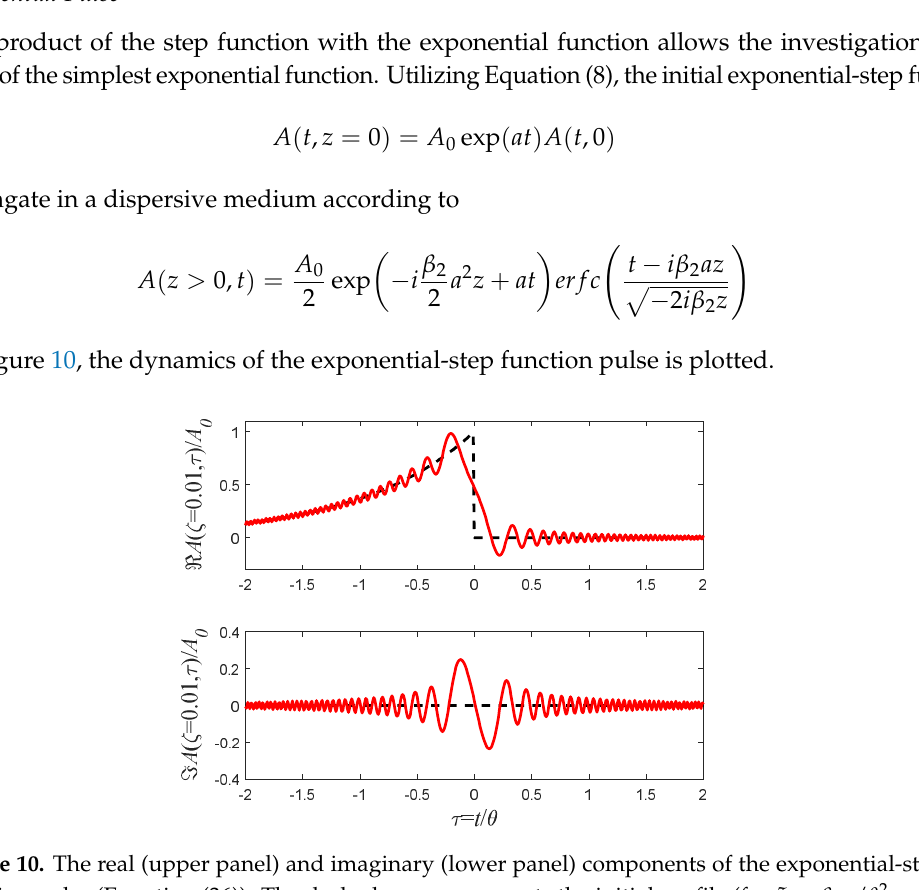
Figure 11. Same as Figure 2, but for the intensity (   2 , ztA ) of the pulse presented by Equation (36). 5.5. Cosine Pulse A bounded cosine pulse is an example of a continuous pulse (unlike the rectangular one), where the discontinuity at the edges of the pulse occurs on the amplitude’s derivative level. It should be stressed that in terms of the pulse's intensity, the derivative is continuous as well. Therefore, this is an important pulse because, for many practical purposes, it mimics a continuous pulse, but at the same time, it is (initially) temporally bounded. In this case, if the initial pulse is